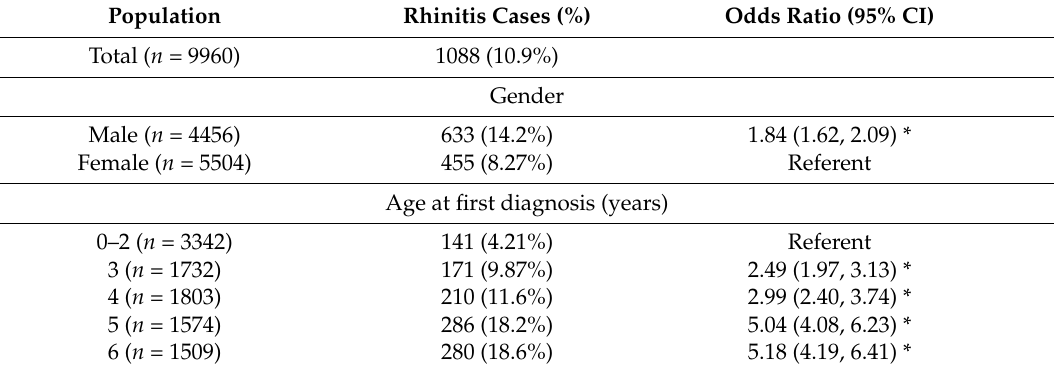
Table 1. Incidence rates of the first occurrence of allergic rhinitis in preschool children by gender and age for 2007–2011.